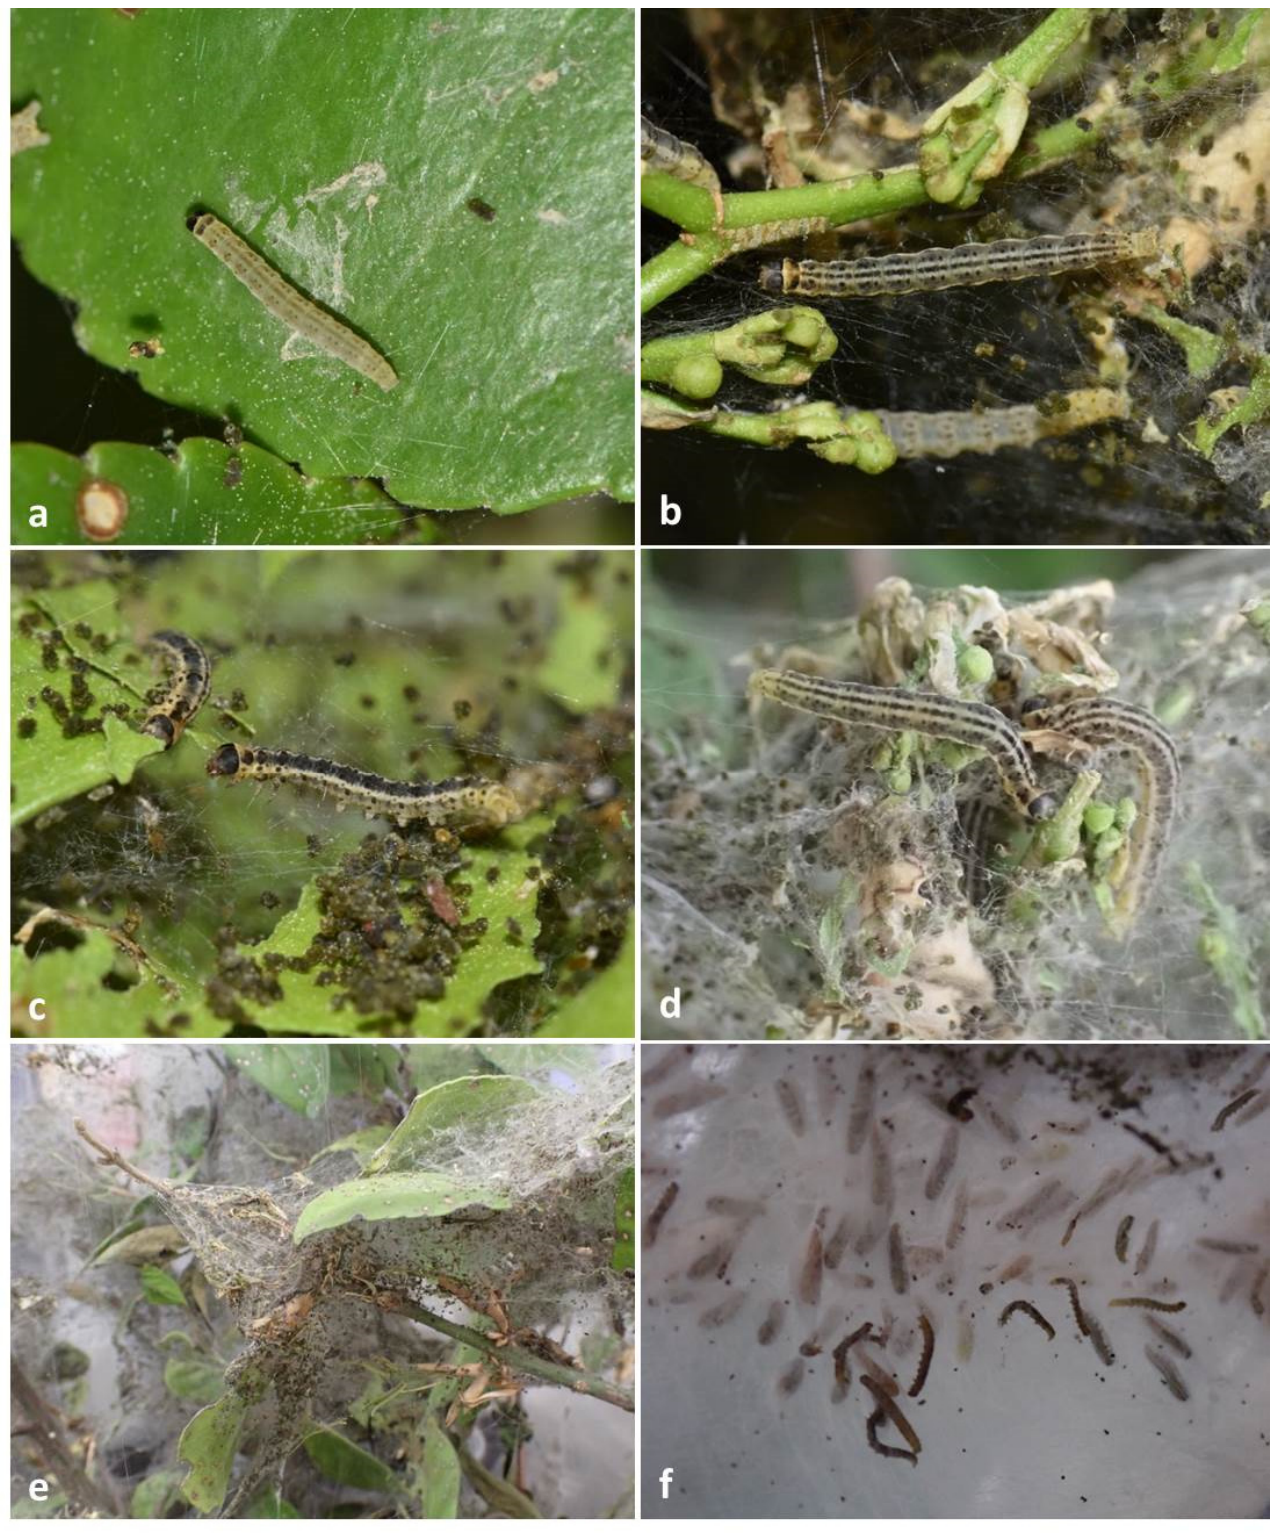
Figure 1. Larva of Yponomeuta meguronis on a colony of Euonymus japonicus Thunb (personal observation): ( a ) early stages (1–2 instars) of larva dorsally tinged with pale brown; ( b , c ) middle to last instar of larvae dorsally tinged with dark gray; ( d , e ), larvae making silk webs; and ( f ) larvae and pupa in silk webs.